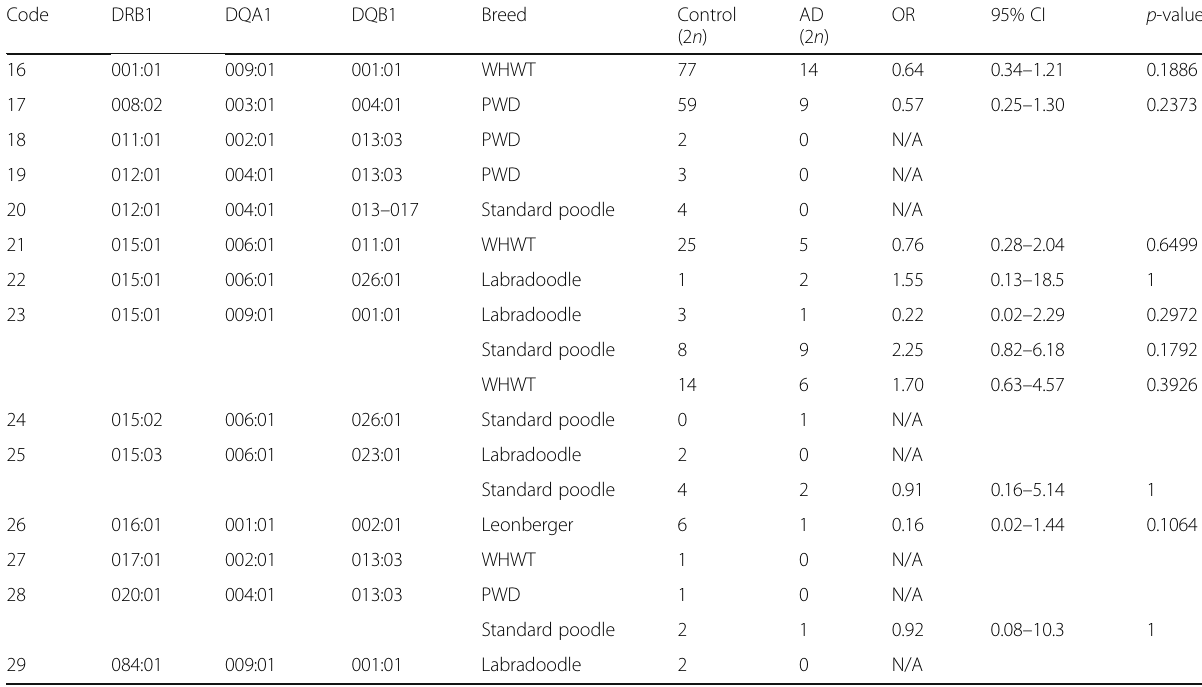
Table 5 Frequency, code and odds ratio (OR) for DLA class II three-locus haplotypes observed in the six studied breeds at increased risk for Addison ’ s disease (AD): bearded collie (61 cases, 122 controls), West Highland white terrier (WHWT; 43 cases, 166 controls), standard poodles (30 cases, 55 controls), Portuguese water dog (PWD; 17 cases, 76 controls), Labradoodle (12 cases, 9 controls) and Leonberger (11 cases, 14 controls)